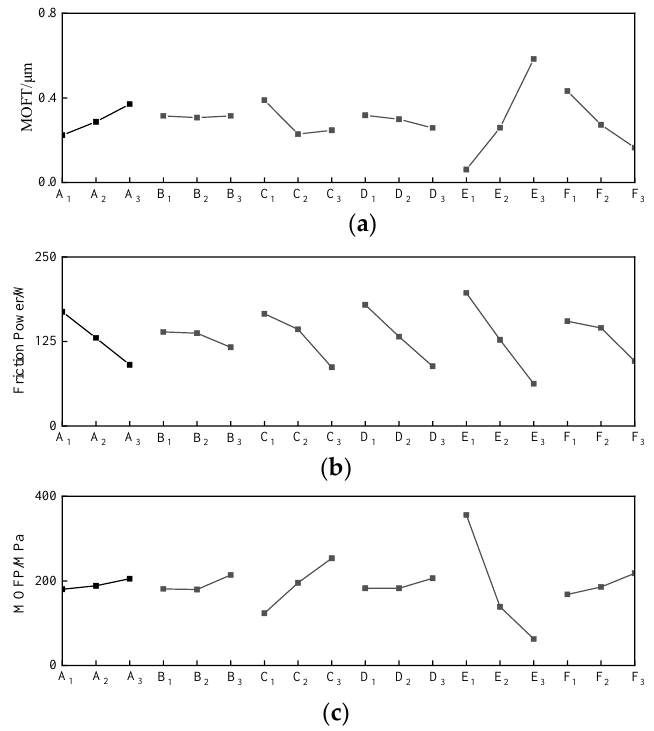
Figure 10. ( a ) MOFT at different factors and levels. ( b ) Friction power at different factors and levels. ( c ) MOFP at different factors and levels.